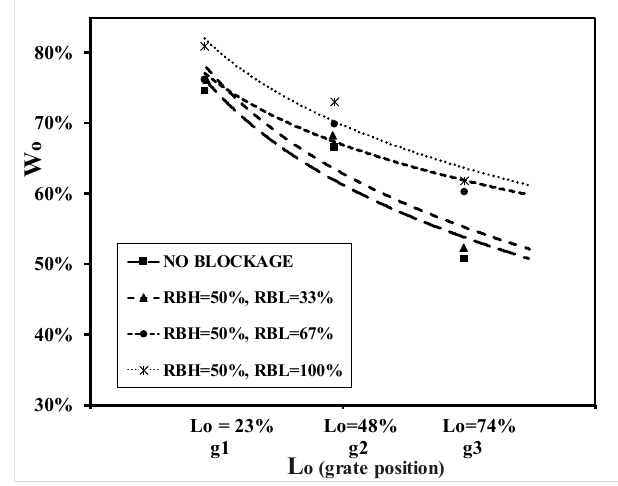
Figure 21. Relationship between WO and LO for different LB at HB 50% at Q = 1.00 L/sec.